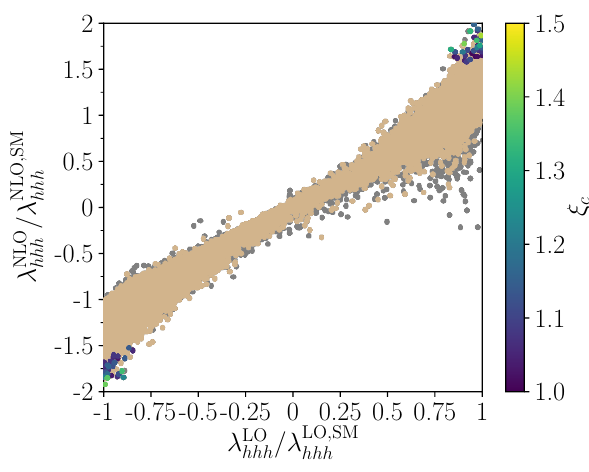
Figure 11 . N2HDM T2: NLO trilinear self-coupling between three SM-like Higgs bosons nor- malised to the SM reference value versus the corresponding LO ratio. The color code is the same as in (cid:12)gure 3. The color bar indicates the strength of the phase transition for (cid:24) c search constraints are